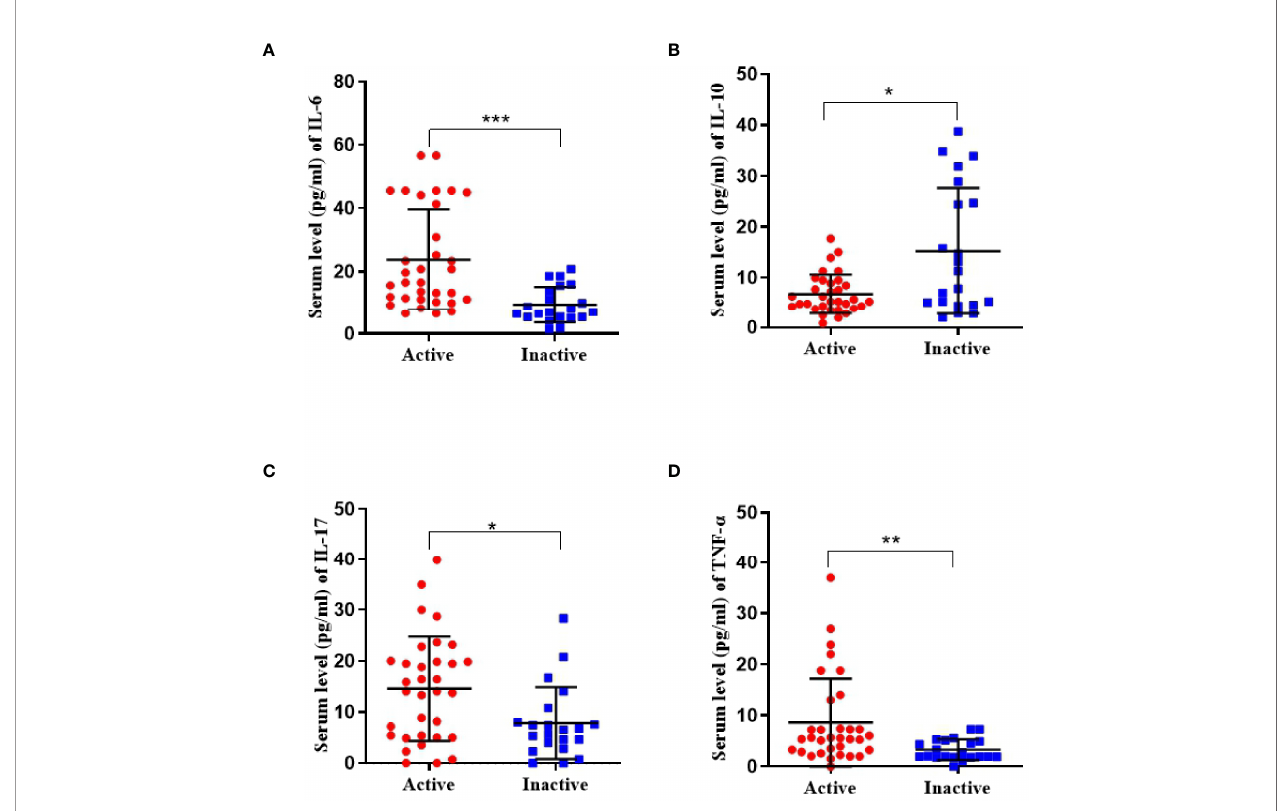
FIGURE 3 | Serum concentrations of cytokine (including IL-6, IL-10, IL-17, and TNF- a ) in active TA patients (n = 36) and inactive TA patients (n = 21). (A, C, D) The concentration of IL-6, IL-17, and TNF- a was signi fi cantly upregulated. (B) That of IL-10 was found reduced. Data were presented as mean ± SD. Shown signi fi cant differences are assessed by the Mann – Whitney U test. *P < 0.05; **P < 0.001, ***P < 0.001. P < 0.05 was considered statistically signi fi